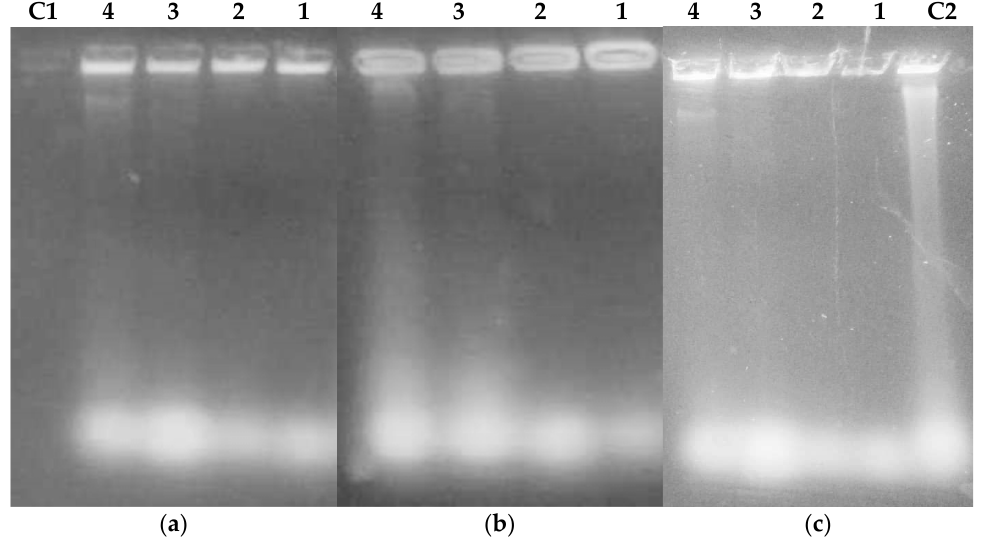
Figure 13. UV visualization of flavonoids treated E. coli ATCC 8739 lysates; ( a ) Chalcone 4 treat- ment, ( b ) Flavanone 8 treatment, ( c ) Flavone 11 treatment; 1 (1× MIC) ( μ g/mL), 2 (2× MIC), 3 (3× ( b ) Flavanone 8 treatment, ( c ) Flavone 11 treatment; 1 (1 × MIC) ( µ g/mL), 2 (2 × MIC), 3 (3 × MIC), MIC), 4 (4× MIC), C1 (Control), C2 (Colistin). 4 (4 × MIC), C1 (Control), C2